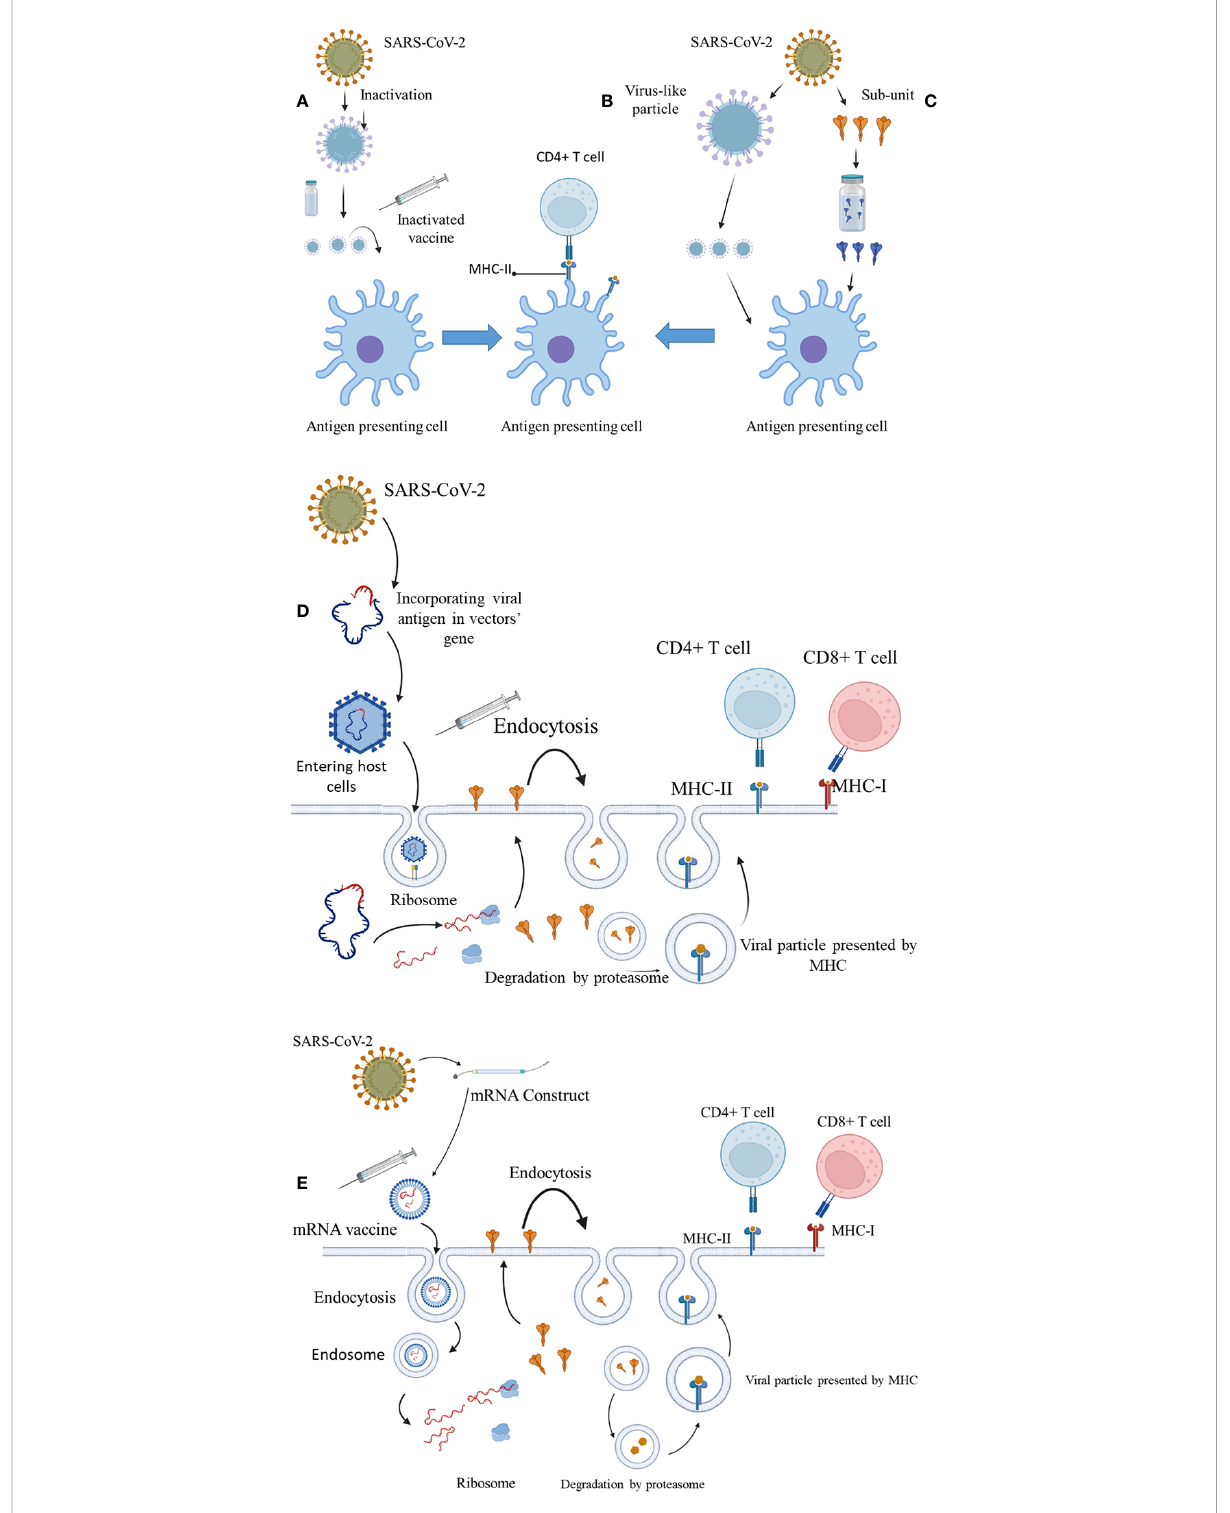
FIGURE 2 The immunogenicity mechanisms of COVID-19 vaccines. (A) Inactivated virus. (B) Virus-like particles. (C) Spike protein subunit. (D) Vector-based vaccines. (E) mRNA construct – based